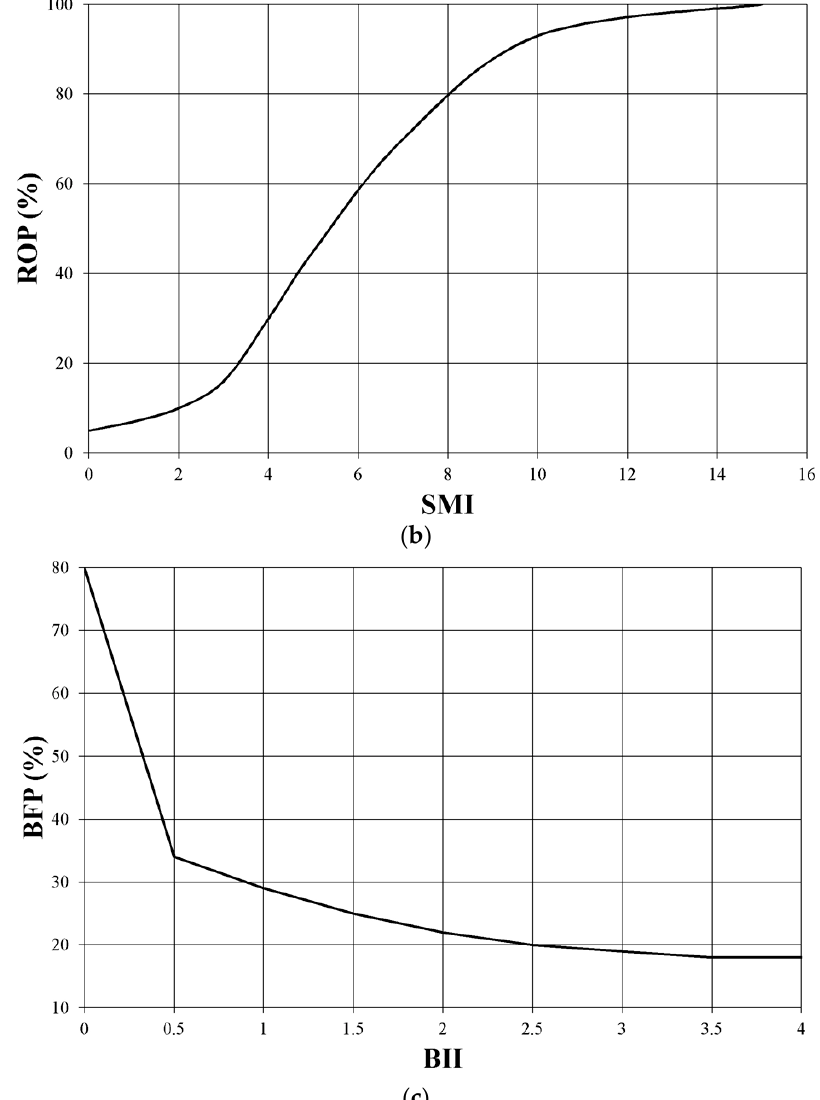
Figure 3. The SSARR model (Ahn et al., 2015): ( a ) Flowchart; ( b ) SMI-ROP; and ( c ) BII-BFP.